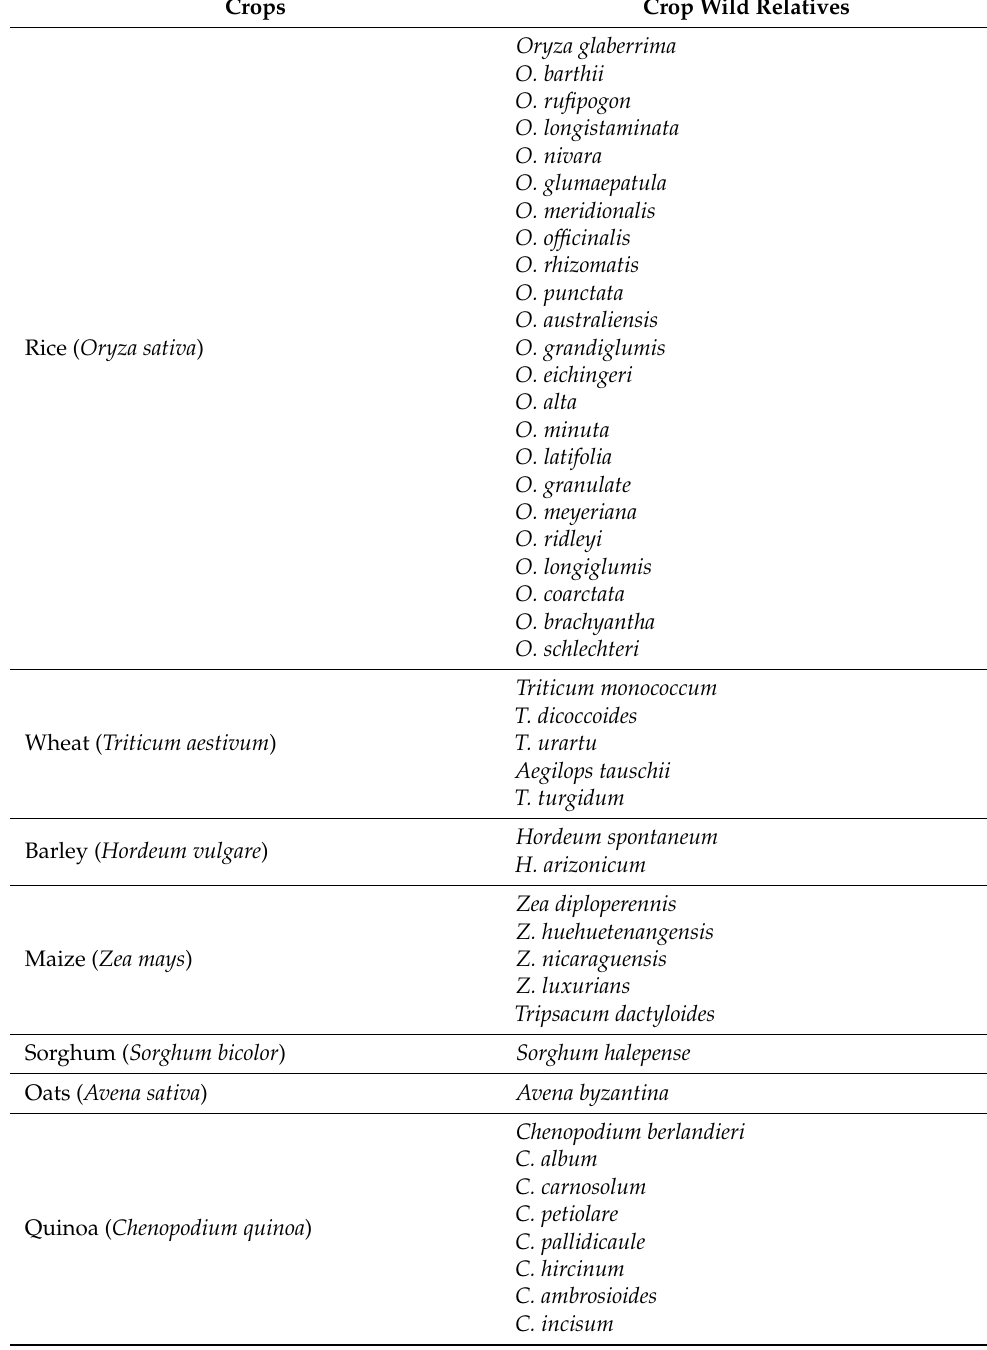
Table 3. Wild relatives of different crops.